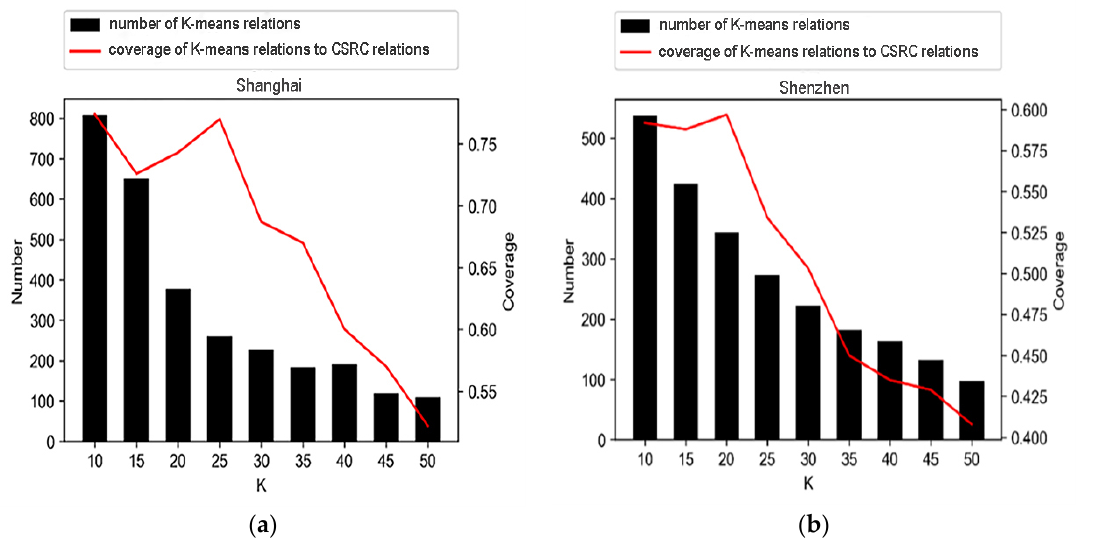
Figure 4. ( a ) The number of K-means relations and its coverage ratio to third-party relations (CSRC) in Shanghai markets under different K values; ( b ) The number of K-means relations and its coverage ratio to third-party relations (CSRC) in Shenzhen markets under different K values. Table 2. Changes in clustering relationships in Shanghai and Shenzhen markets using different K values. Market K